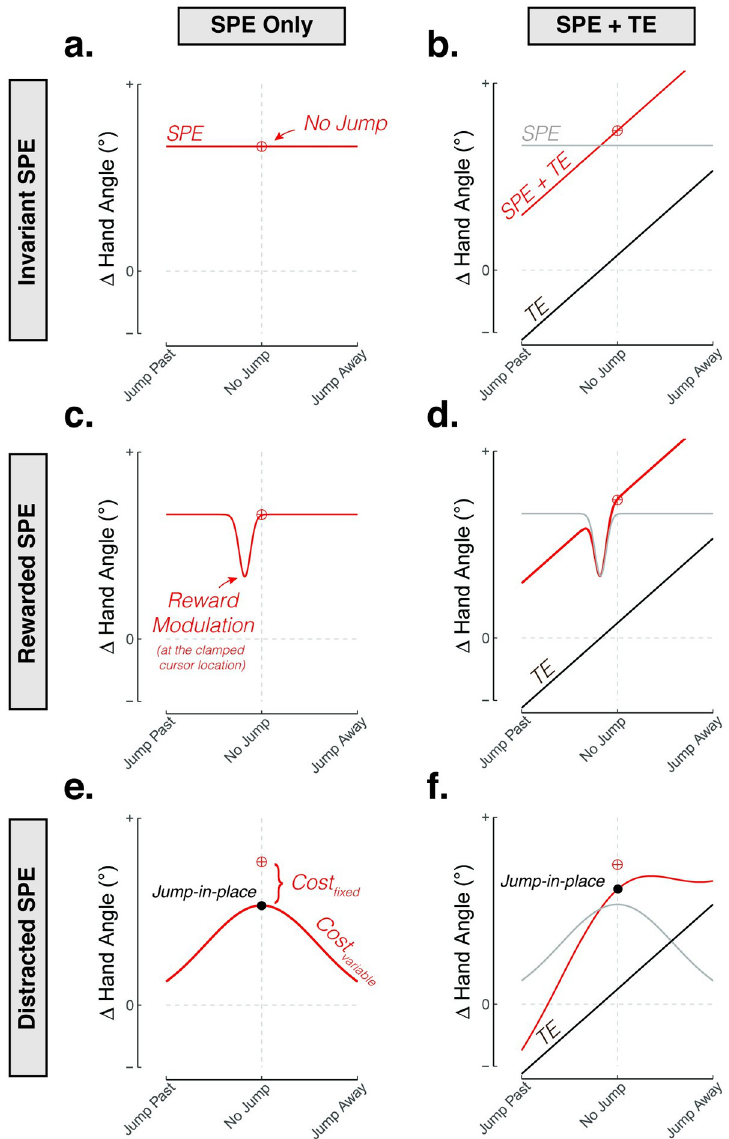
Fig 4. Modeling the influence of target jumps on adaptation to TE and SPE. Given a constant SPE magnitude, SPE may be (a) impervious to target jumps (c) attenuated when the cursor “hits” the (jumped) target (modulated by intrinsic reward), or (e) attenuated due to the motion of the jumping target diverting attention away from computing a SPE. The attenuation is assumed to be driven by the mere presence of a target jump (fixed cost–an effect isolated by flickering the target, also known as the jump-in-place condition) and varied with target jump size (variable cost). Right column (b) , (d) , (f) : Adaptation may also be driven by a TE-based learning process, assumed here to be a linear function of the distance between the feedback and new position of the target. Note that TE is 0 at the clamped cursor location. The red indicates expected behavior, which is the composite of the SPE process (grey) and TE-based process